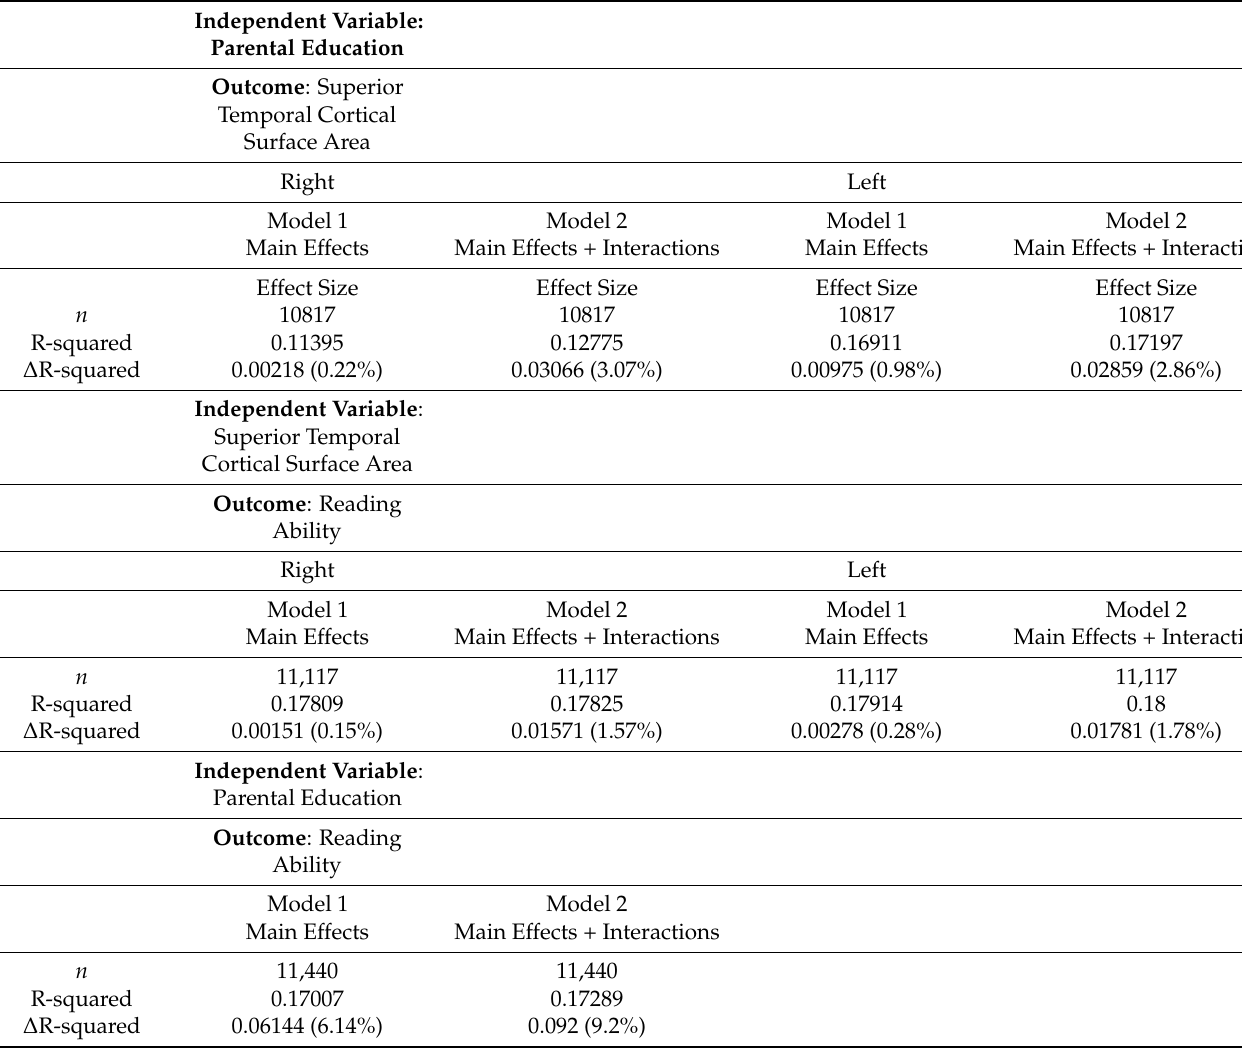
Table 2. Variance in outcomes explained by each